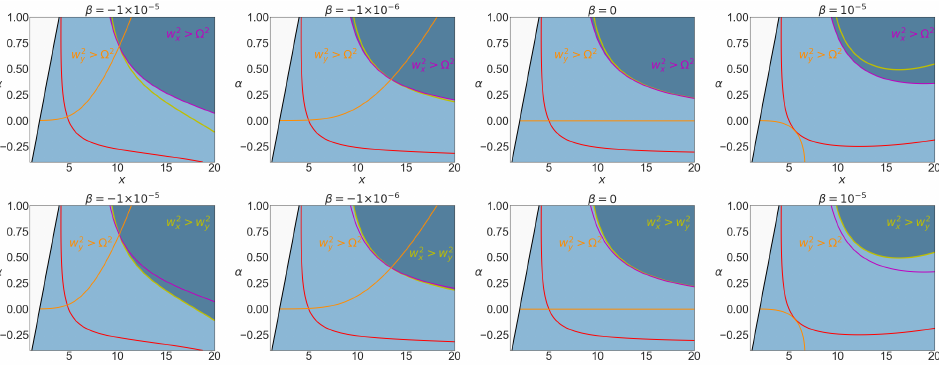
Figure 6. The different epicyclic frequencies in the ( x , α )-plane are examined. On all the plots, the yellow line depicts w 2 x = w 2 y , the pink line shows w 2 x = Ω 2 , and the orange line is w 2 y = Ω 2 . The light blue area corresponds, as in Figures 4 and 5, to the area where circular orbits exist (bounded by the thick black line 2 S − x = 0), and above the red line, the orbit is stable with respect to perturbations in both directions. In the panel, in the first row, the darker blue area satisfies w 2 x > Ω 2 . In the second row, the darker blue area satisfies w 2 x > w 2 y . By considering the first and second rows together, one can have different ordering for these frequencies.